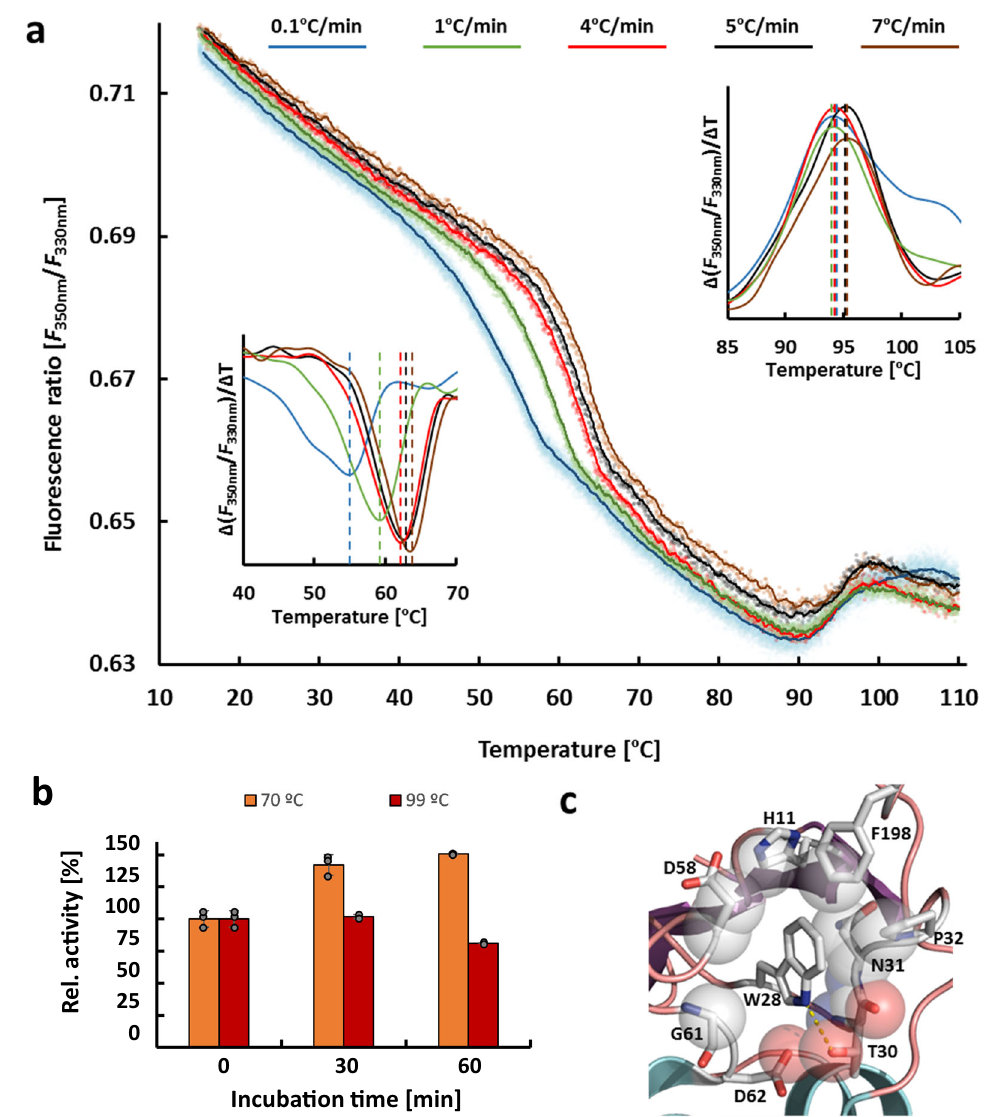
Fig. 5 Two-step thermal unfolding pathway of Igni18. Effect of temperature heating rates on the thermal unfolding of native Igni18 analyzed by nanoDSF, measuring the intrinsic protein fl uorescence from 15 °C to 110 °C ( a ). Incubation at 70 °C activates the protein whereas periods longer than 30 min at 99 °C are irreversible and lead to activity loss ( b ). Error bars represent the relative standard deviation ( n = 3 independent experiments). The binding pocket of W28, used for the analysis, shows a strong hydrophobic character ( c